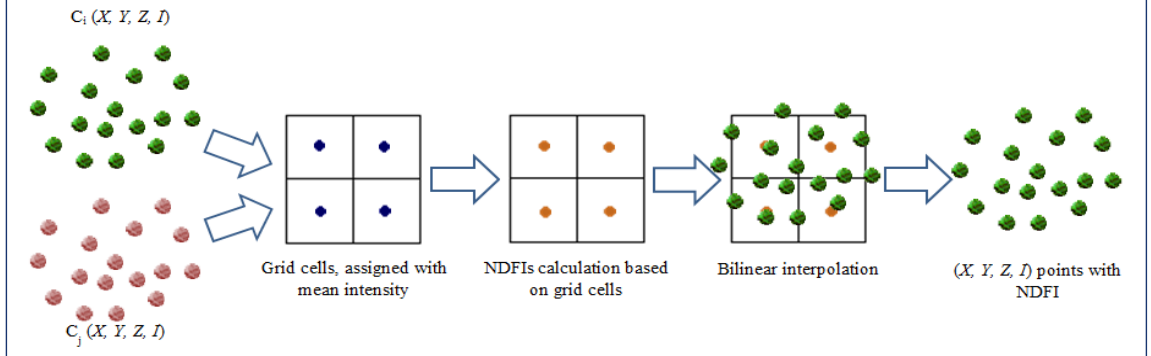
Figure 6. NDFIs calculation for 3D